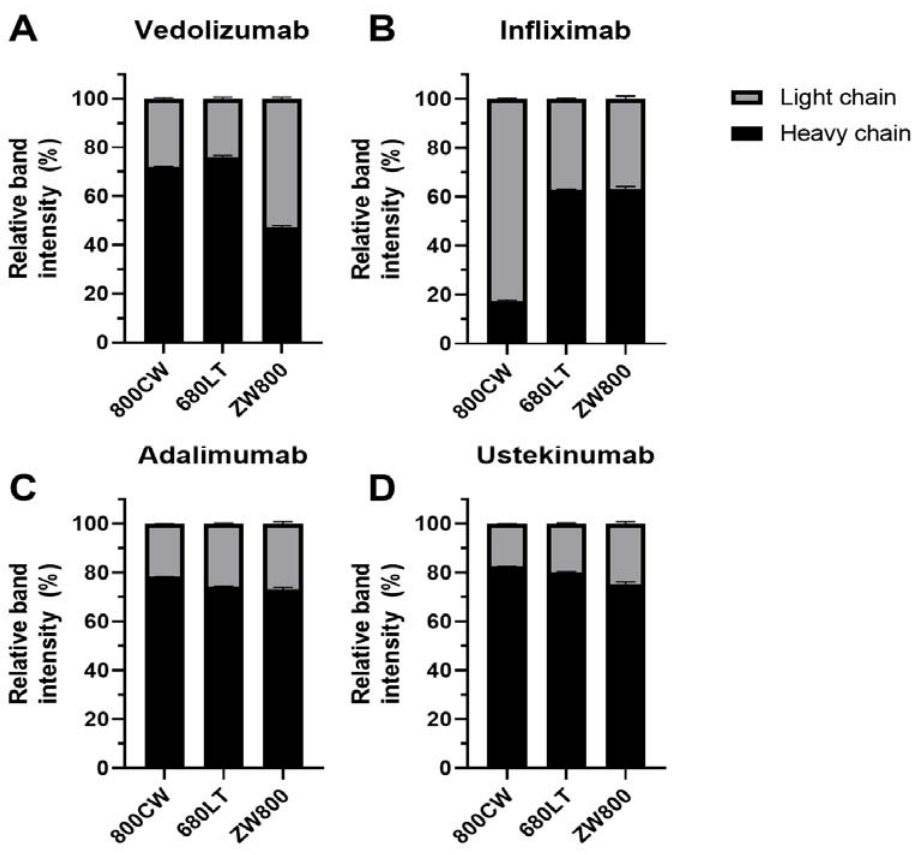
Figure 4. Relative distribution of dye signals across heavy and light chains measured on sodium dodecyl sulfate polyacrylamide gel electrophoresis (SDS-PAGE). ZW800 conjugates did not have visible heavy and light chain signal, data displayed from regions of interest placed at the estimated band position based on coomassie. Adalimumab ( C ) and ustekinumab ( D ) show similar distribution patterns, where dye is mostly on the heavy chain (range adalimumab: 73.1–78.2%, ustekinumab 75.3–82.5%). Infliximab-800CW ( B ) shows a very low amount of heavy chain binding (17.4%). Light chain binding is also seen to a lesser extent in other infliximab conjugates (680LT: 62.8% HC; ZW800: 63.1% HC). Vedolizumab ( A ) shows mostly heavy chain binding, but shows more per-dye fluctuation than other antibodies (800CW: 72.0% HC; 680LT: 75.9% HC; ZW800-1: 47.3% HC). Increased light chain binding could be related to tracer instability.